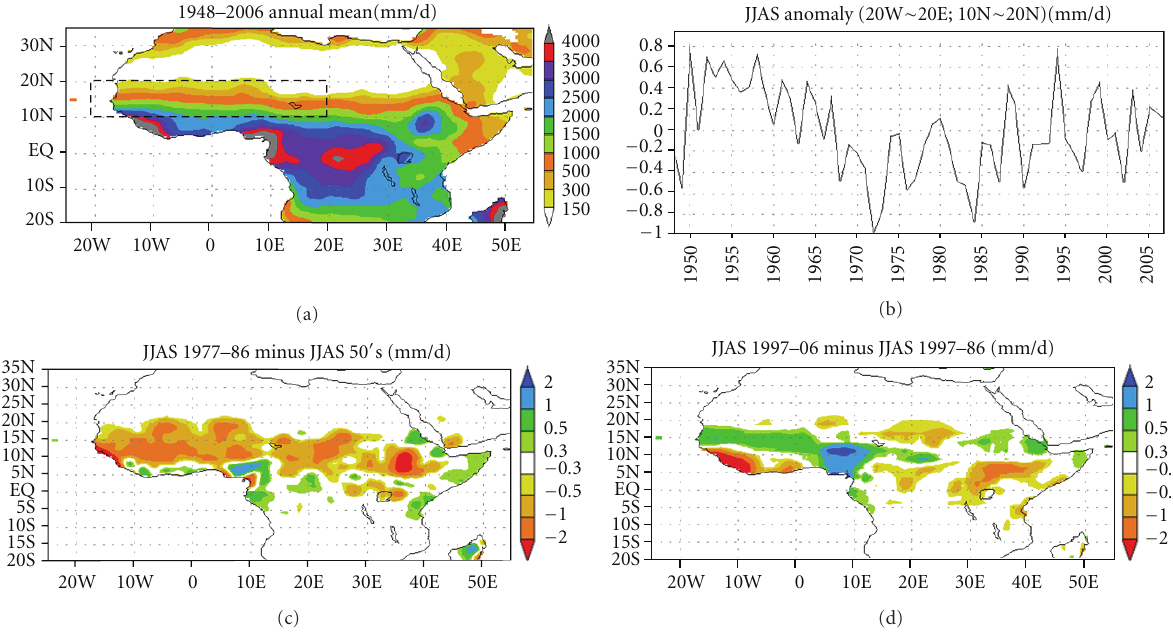
Figure 1: (a) Observed climate annual mean precipitation (mmday − 1 ); (b) time series of June-July-August-September (JJAS) mean precipitation (mmday − 1 ) averaged over 20 ◦ W to 20 ◦ E and 5 ◦ N to 20 ◦ N (the box outlined in (a)); (c) observed JJAS precipitation di ff erence (mmday − 1 ) between the 1980s and the 1950s; (d) observed JJAS precipitation di ff erence (mmday − 1 ) between 1996–2006 and 1976–1987. Data Sources: National Center for Environmental Prediction Climate Prediction Center Merged Analysis of Precipitation (CMAP,